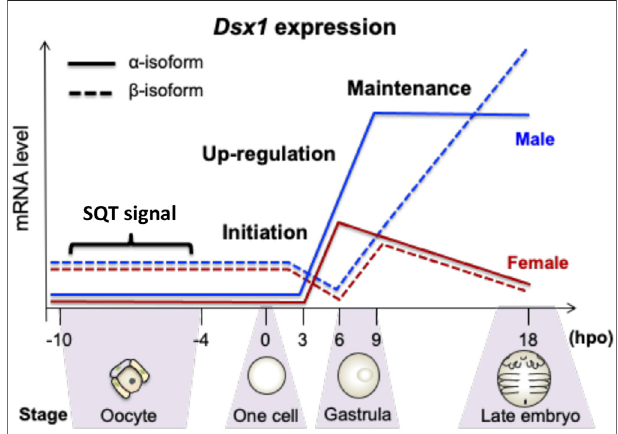
FIGURE 4 | Temporal expression patterns of Dsx1 isoforms during late oogenesis and early embryogenesis. hpo, hour post ovulation; SQT, sesquiterpenoid. Adapted from Mohamad Ishak et al. (2017).